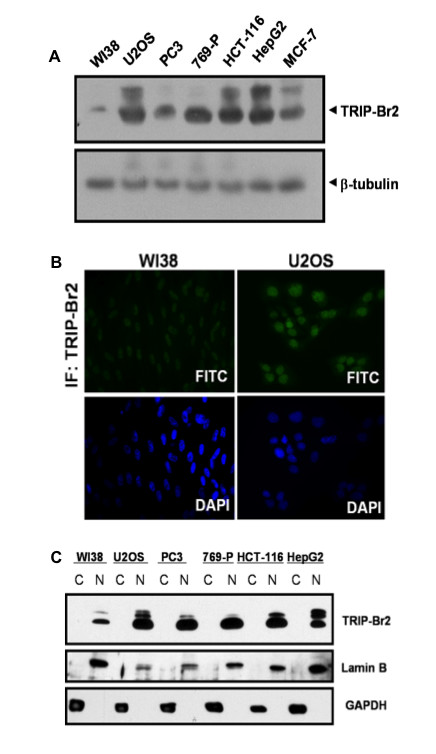
TRIP-Br2 expression is dysregulated in many human cancer cell lines. (A) Western blot analyses revealed overexpression of TRIP-Br2 in the human cancer cell lines U2OS, PC3, 769-P, HCT-116, HepG2 and MCF-7. Data was obtained from three independent experiments that were performed in triplicates. (B) Immunocytochemical analyses showed that TRIP-Br2 is found predominantly in both the nuclei of WI38 and U2OS cells. Cellular DNA was counterstained with DAPI (blue). (C) Subcellular fractionation analyses revealed that TRIP-Br2 is overexpressed and preferentially localized to the nuclei of U2OS, PC3, 769-P, HCT-116 and HepG2 cells. Data was obtained from three independent experiments that were performed in triplicates.